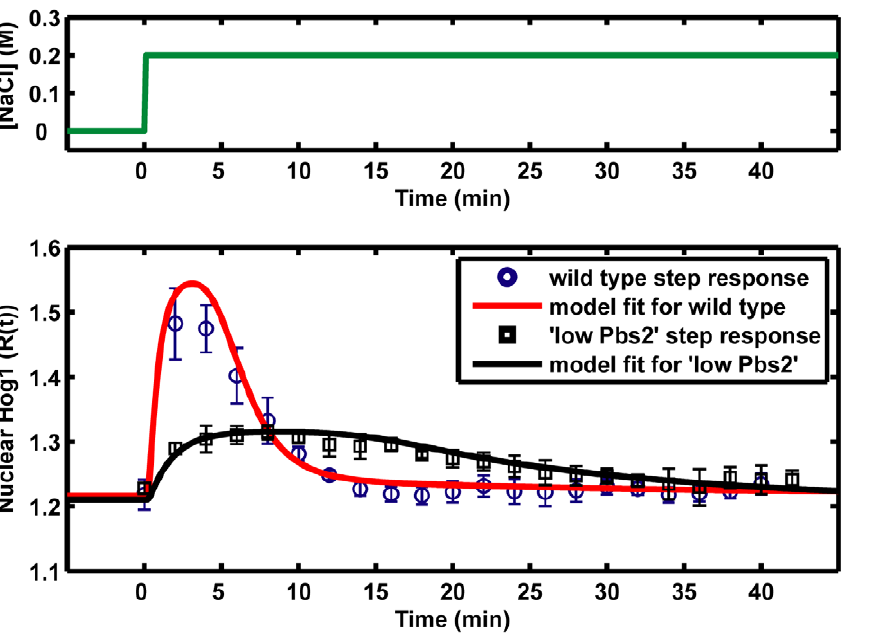
Figure 2. Comparison of model fits to the experimental data sets for step increase of 0.2 M NaCl in wild-type yeast and ‘‘low Pbs2’’ mutant. Circles and squares represent the experimental data sets from Fig. 2D in reference [10]. The solid curves are the simulation result from our model. For the ‘‘low Pbs2’’ mutant, we set Pbs2 concentration in the model to be 12.55% of the corresponding Pbs2 in the ‘‘wild type’’.